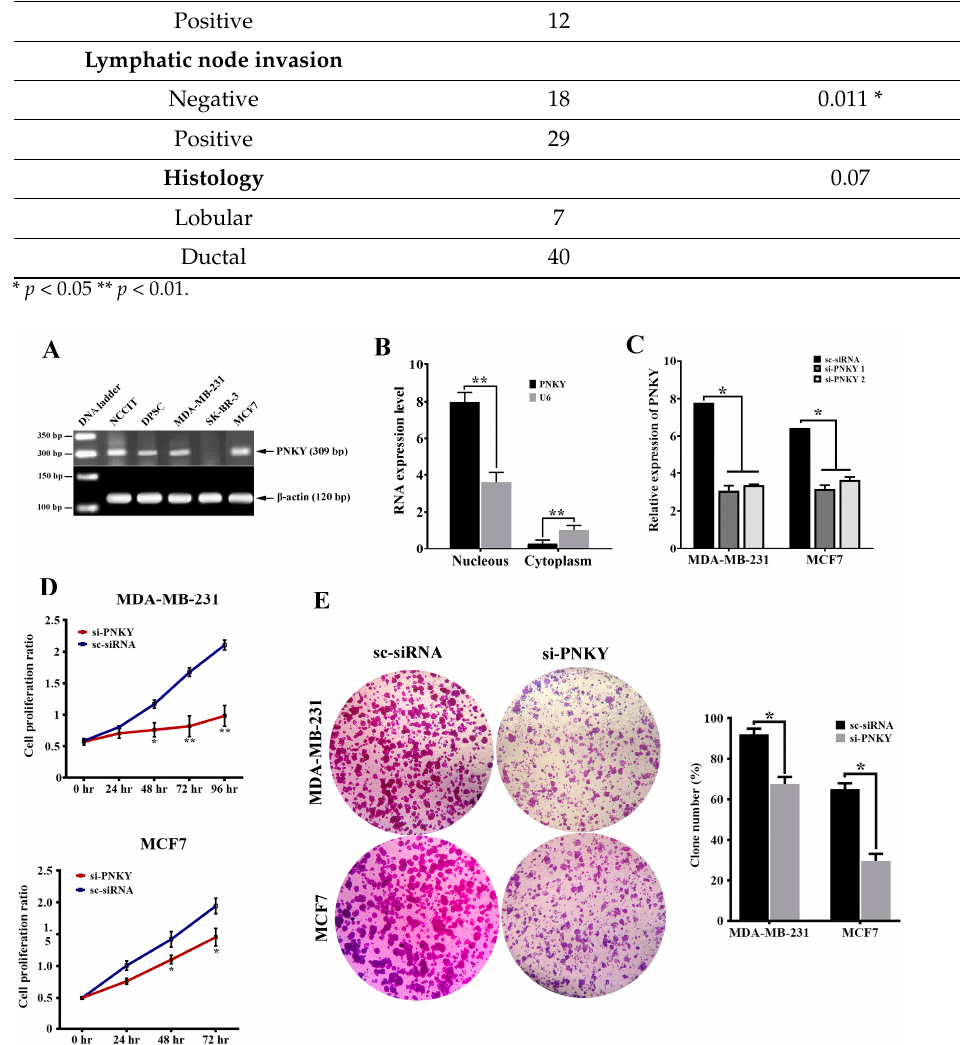
Figure 2. PNKY is expressed in stem/cancer cells and promotes cancer cells proliferation. ( A ) The expression profile of PNKY in cancer/stem cells showed that it is expressed in NCCIT, DPSC, MDA-MB-231, and MCF7 cells. ( B ) The PNKY transcript is localized in the nucleus of breast